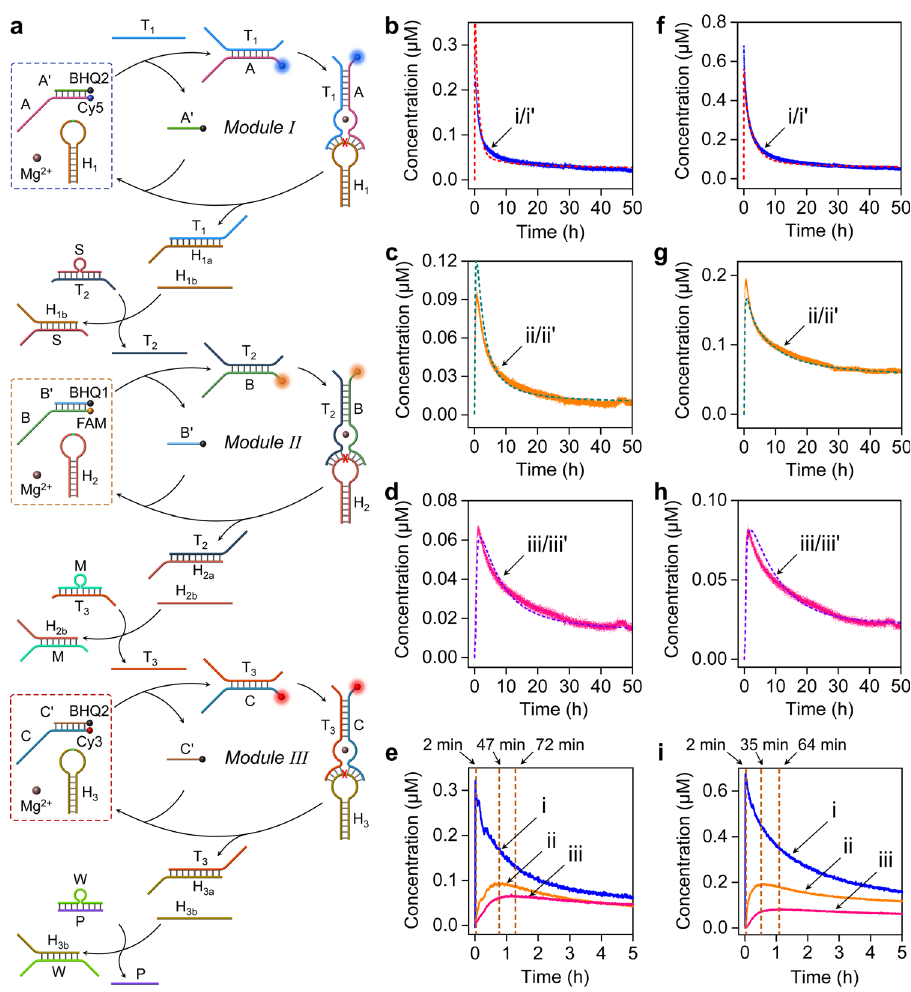
Fig. 3 | Triggered operation of a three-layer transient DNAzyme cascade. a Schematic T 1 -triggered transient operation of the three-layer DNAzyme cascade. The dynamic, transient formation and depletion of DNAzyme T 1 /A, T 2 /B and T 3 /C are followed by the transient fl uorescence changes of the fl uorophores associated with the dynamic modules. b – e Time-dependent transient concentration changes oftheDNAzymeconstituentsinthethree-layercascadetriggeredbyT 1 =1.8 μ M(A/ A ’ 1.8 μ M, H 1 9 μ M, S/T 2 1.8 μ M,B/B ’ 0.6 μ M, H 2 3 μ M,M/T 3 0.6 μ M, C/C ’ 0.2 μ M, H 3 1 μ M, W/P 2 μ M): ( b )-DNAzyme T 1 /A operating in module I: Experimental transient (i)-solid curve; computational simulated transient using the kinetic model, Sup- plementary Fig. 33, (i ’ )-dashed line. ( c )-DNAzyme T 2 /B operating in module II, (ii)- experimental transient, (ii ’ )-computational simulated transient. ( d )-DNAzyme T 3 /C operating in module III, (iii)-experimental transient, (iii ’ )-computational simulated